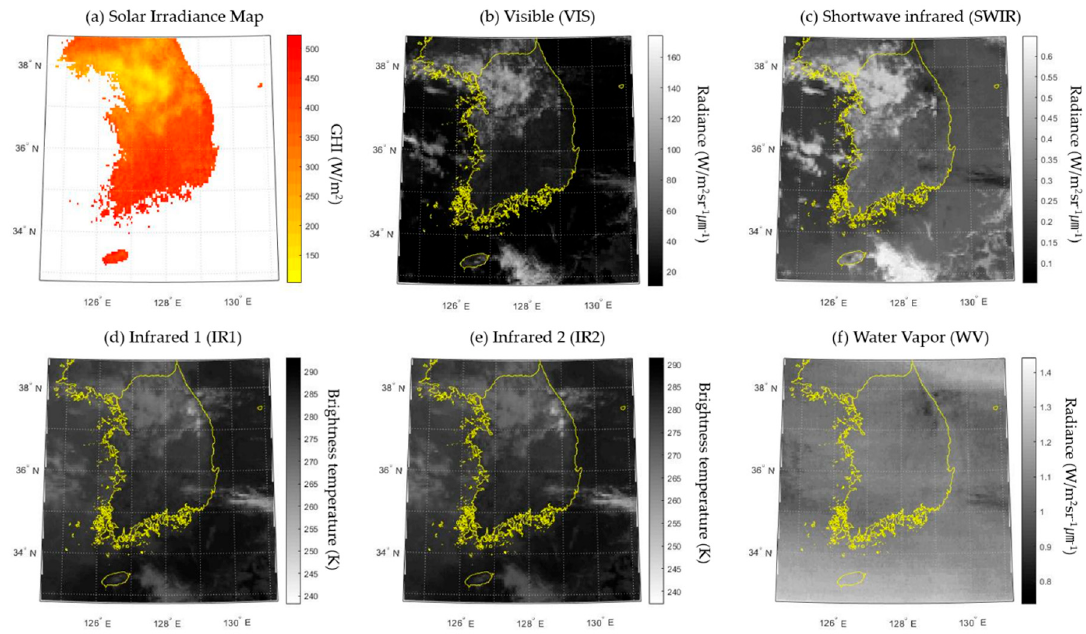
Figure 12. Generated solar irradiance map and five input COMS images at 14:00 1 January 2017 (KST).